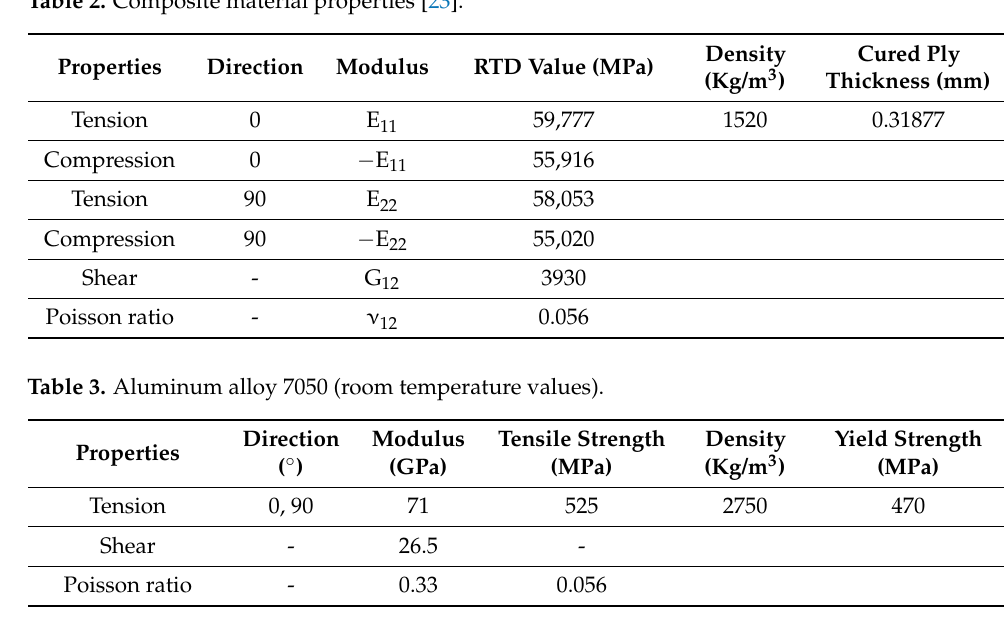
Table 2. Composite material properties [23].